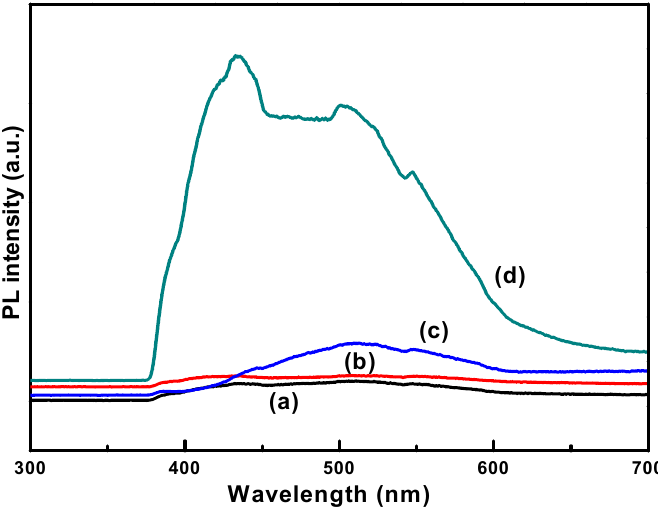
Figure 5 . PL spectra of ( a ) CuIm ( b ) CuZrIm0.5 ( c ) CuZrIm1 ( d ) CuZrIm1.5 . Figure 5. PL spectra of ( a ) CuIm ( b ) CuZrIm0.5 ( c ) CuZrIm1 ( d ) CuZrIm1.5.